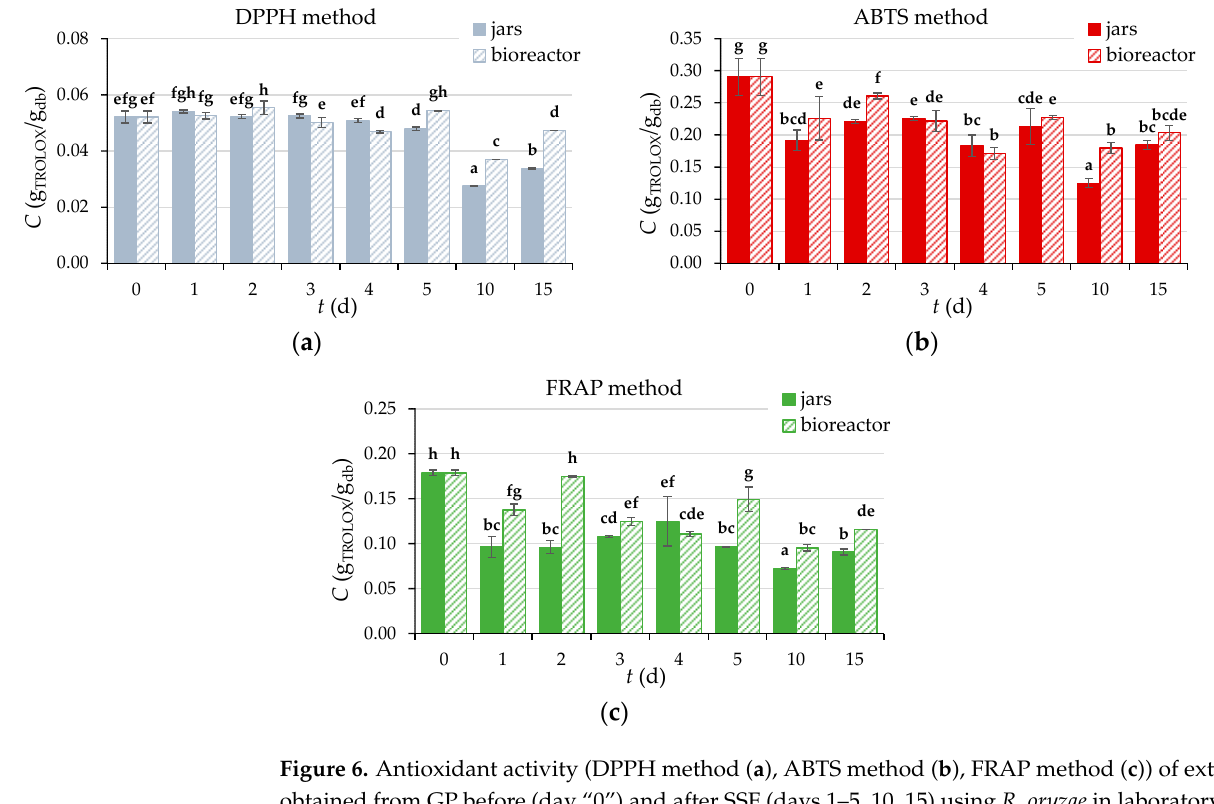
methods (DPPH, ABTS, and FRAP) based on different reaction mechanisms were used in this work. Biological treatment of GP with R. oryzae reduced antioxidant activity measured by DPPH, ABTS, and FRAP methods by 35%, 37%, and 49% in laboratory jars, respectively, and by 10%, 30%, and 35% in a tray bioreactor, respectively, after 15 days of SSF. Leite Figure 5. The content ( C ) of total phenolic compounds, TPC ( a ), total fl avonoids, TF ( b ) and total et al. [48] investigated the effects of using different microorganisms and substrates in SSF extractable proanthocyanidins, TPA ( c ) in extracts obtained from GP before (day “0”) and after SSF on TPC yield and antioxidant activity. Cultivation of R. oryzae on GP (a mixture of white with R. oryzae in laboratory jars and tray bioreactor (days 1–5, 10, 15). Samples marked with di ff erent and black GP) resulted in an increase in TPC yield and antioxidant activity, while the use lowercase le tt ers of the alphabet are statistically signi fi cantly di ff erent from each other ( p < 0.05, of grape seeds as a substrate had the opposite effect and resulted in a decrease after seven post-hoc Duncan’s multiple range test). days of fermentation.